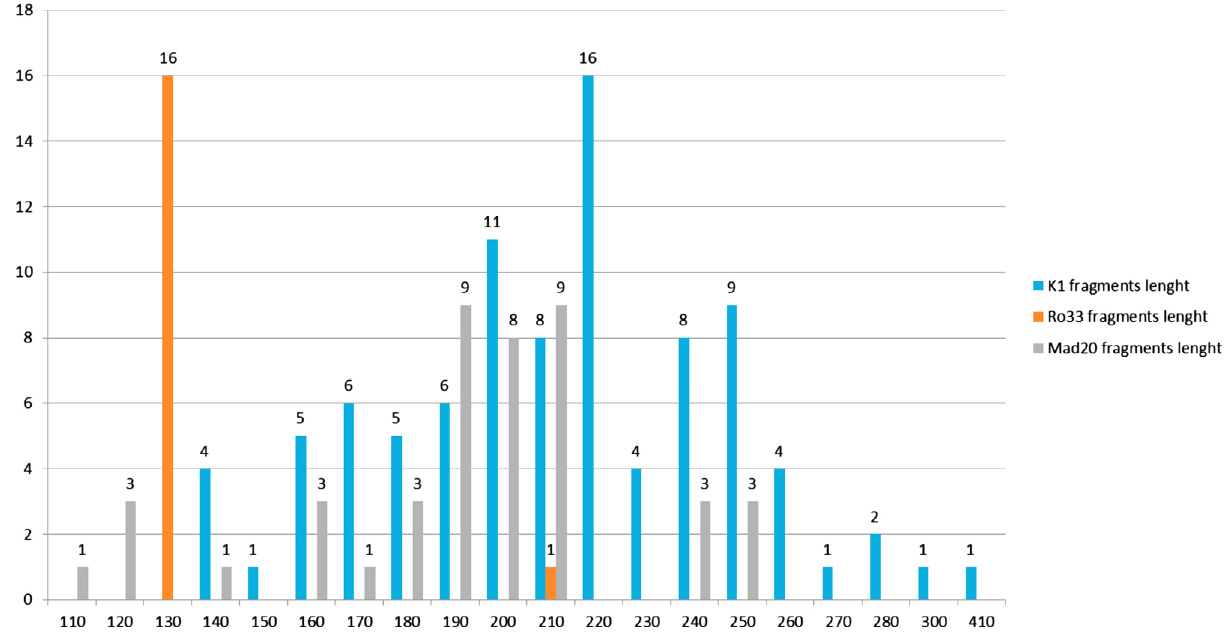
Figure 1. K1, Ro33, and Mad20 allele distribution according to their length (base pairs).